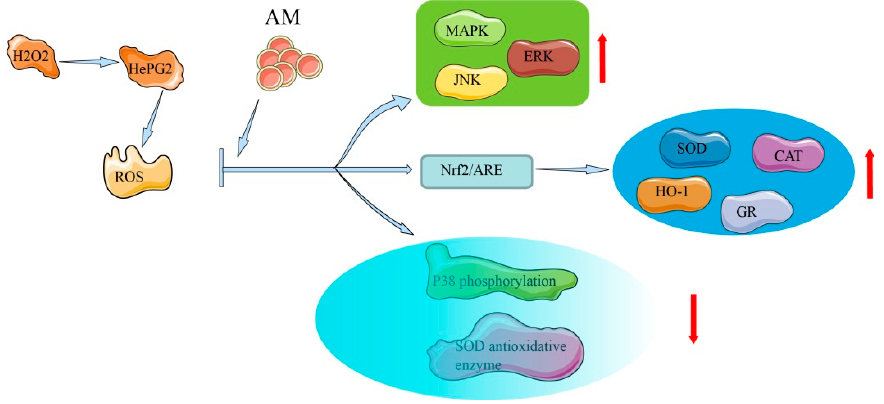
Figure 4. Mechanism of AM for its antioxidative and hepatoprotective effects. In human liver-derived HepG2 cells, AM exhibits hepatoprotective activity (half- maximal effective concentration [EC 50 ] = 88.2 ± 2.8 µ M) against tacrine-induced cyto- toxicity, demonstrating moderate liver protection compared with silybin (EC 50 = 69.0